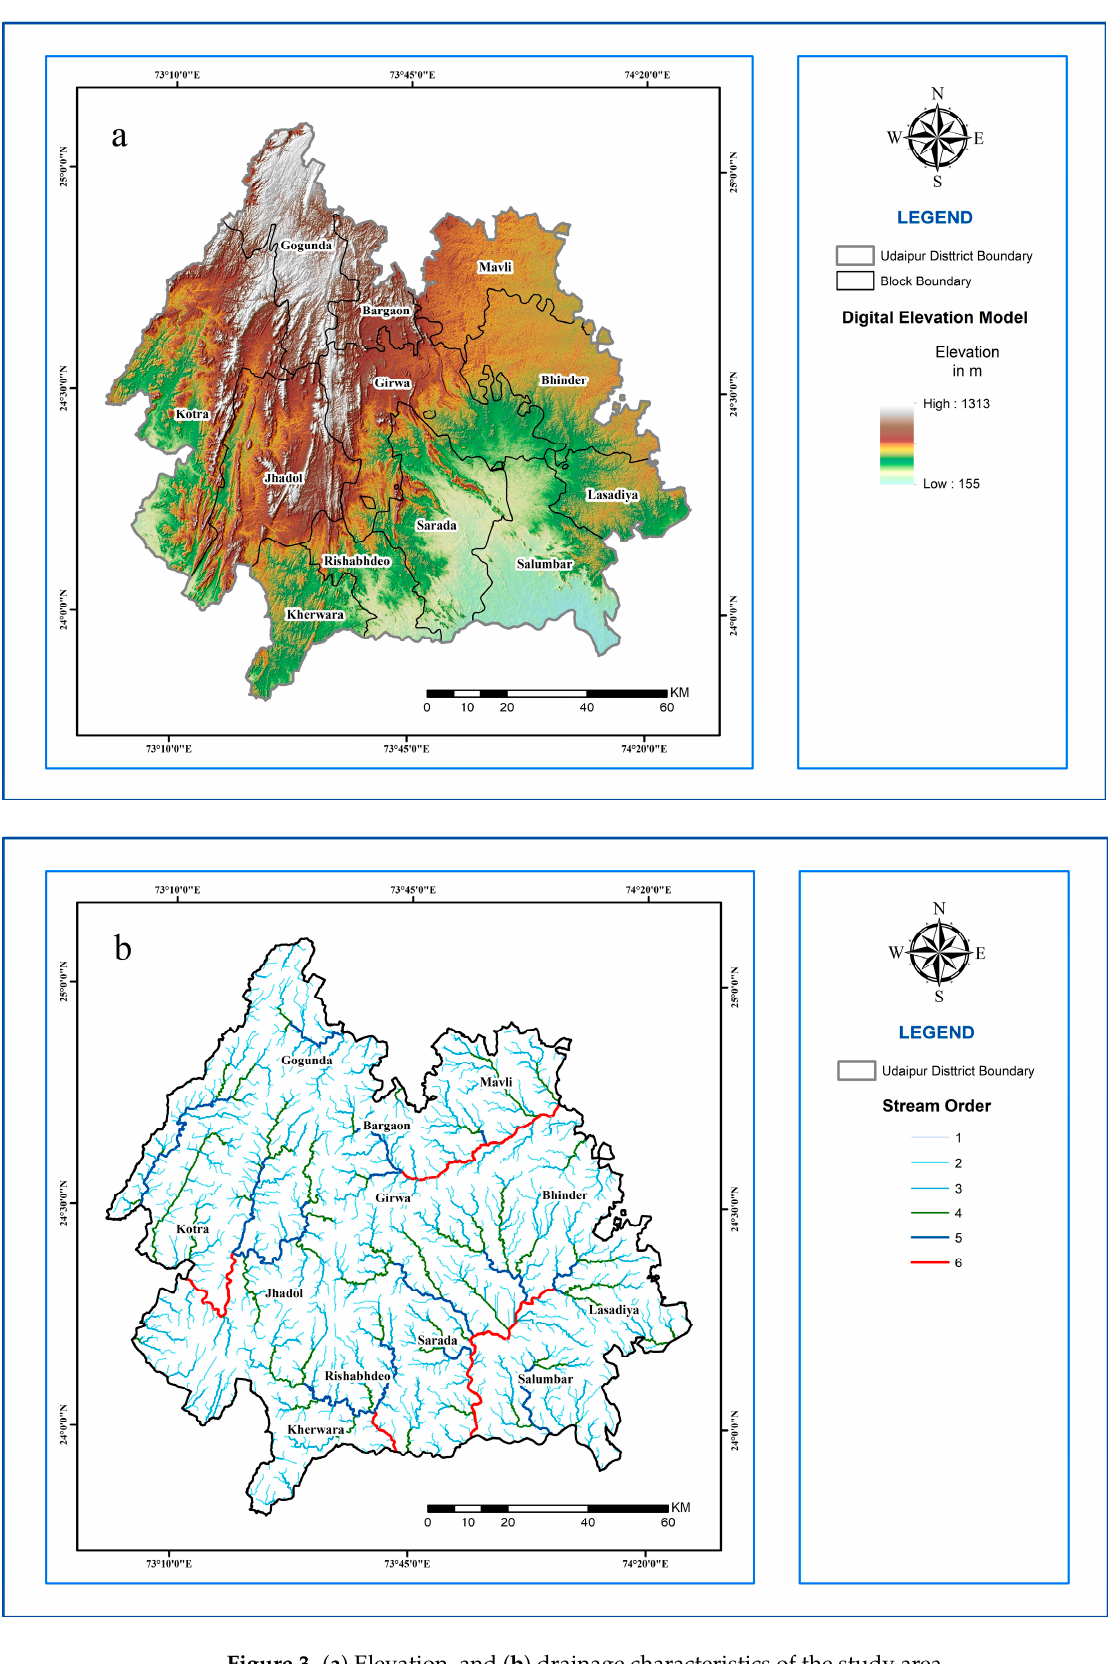
Figure 3. ( a ) Elevation, and ( b ) drainage characteristics of the study area.